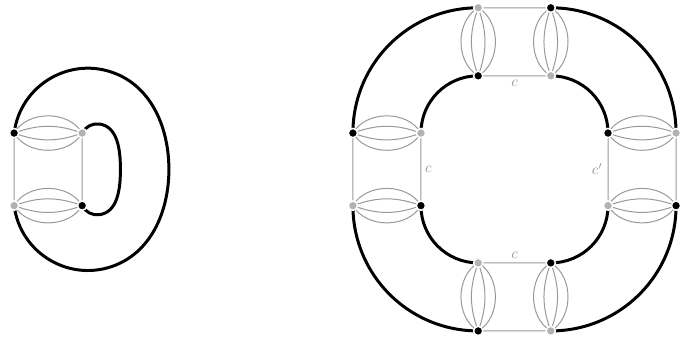
Figure 8: A length-one and a length-four non-melonic divergent vacuum connected necklaces. Remark that the left necklace diverges a N 2 , whereas the right one di- verges as log N if c (cid:48) (cid:54) = c .